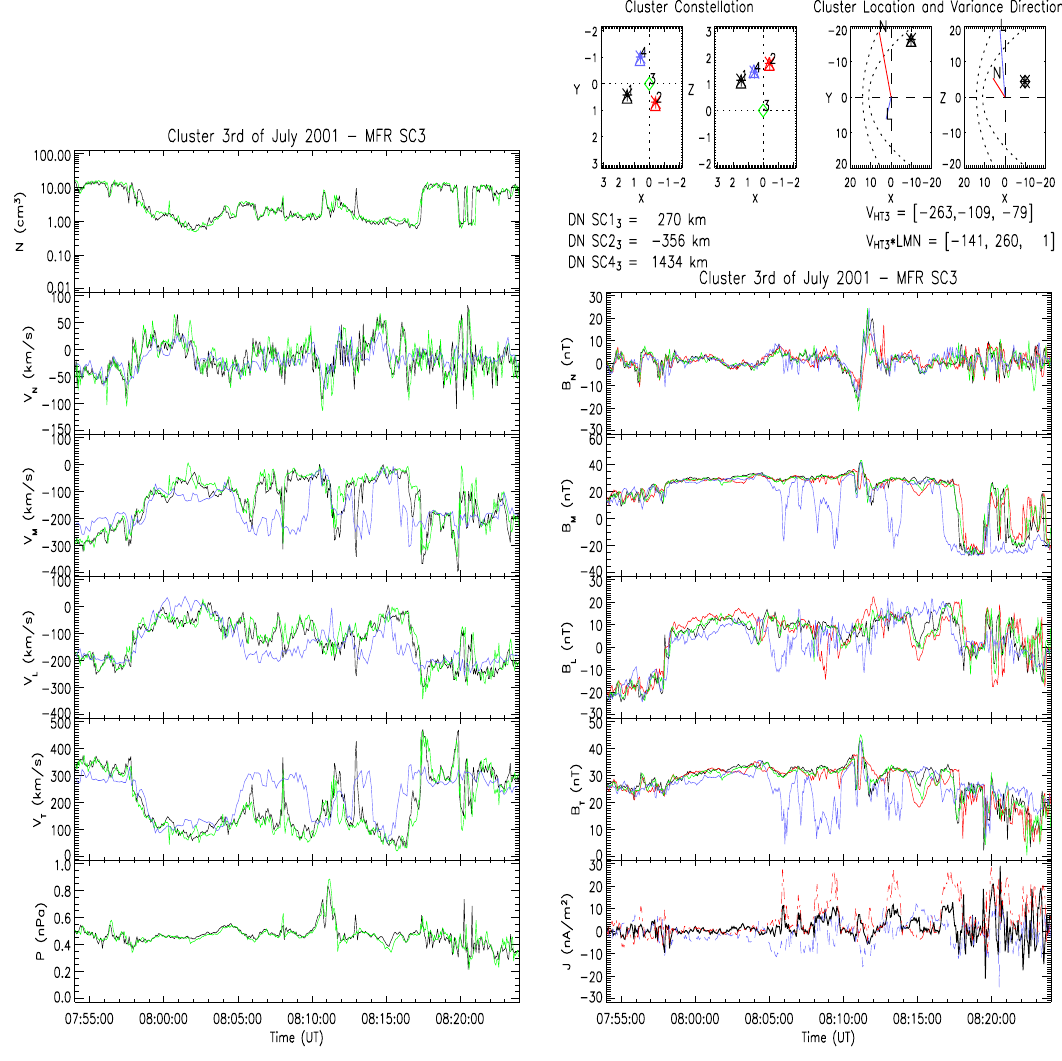
Fig. 14. Plasma (left) and magnetic field (right) observations between 07:54–08:24 UT in the boundary normal coordinates of sc3. Figure uses same format as Fig.